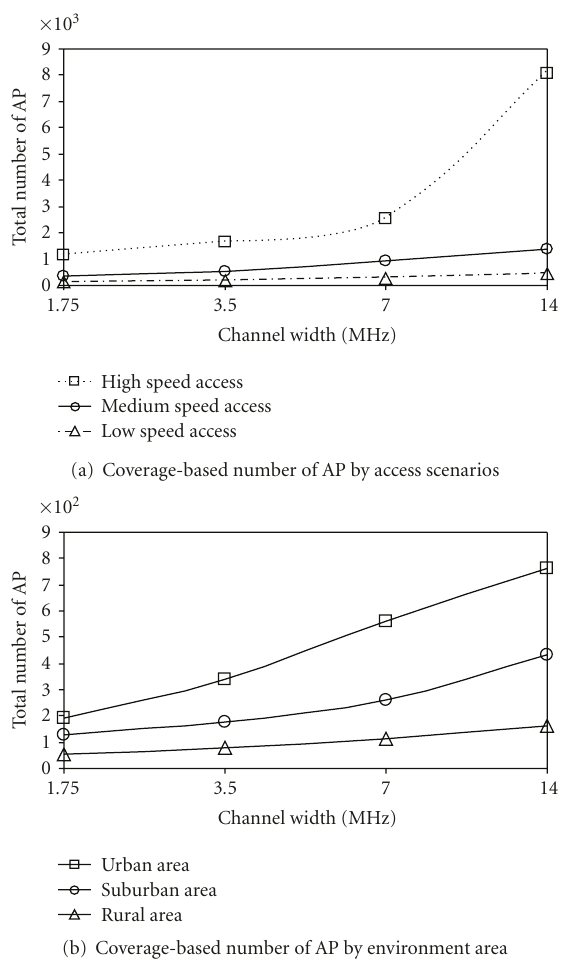
Figure 8: Number of AP from coverage planning.